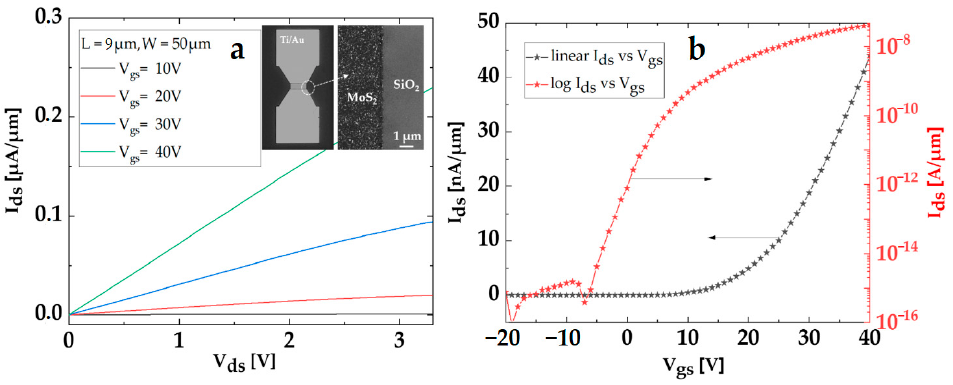
Figure 6. Electrical performance of a FET device on a vertical MoS 2 nanosheet. ( a , b ) Typical output and transfer characteristics of a lateral device; inset shows the SEM image of a fabricated device.